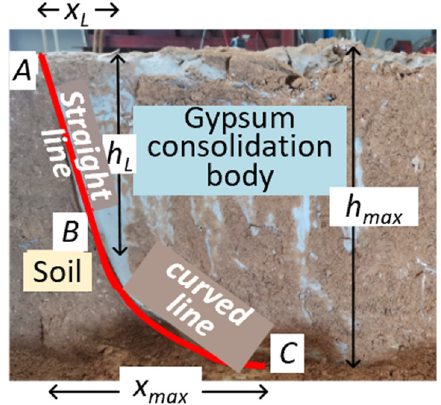
Figure 11. Division of erosion surface geometry.